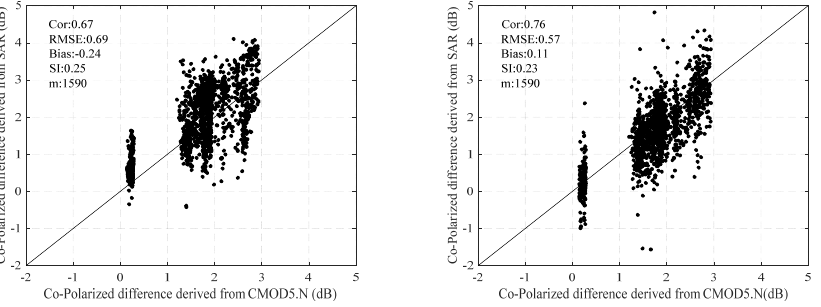
Figure 8. The comparison between co-polarization difference from CMOD5.N and GF-3 SAR. Left column presents the original SAR measurement; right column presents the compensated SAR measurement with removal of residual amplitude error.